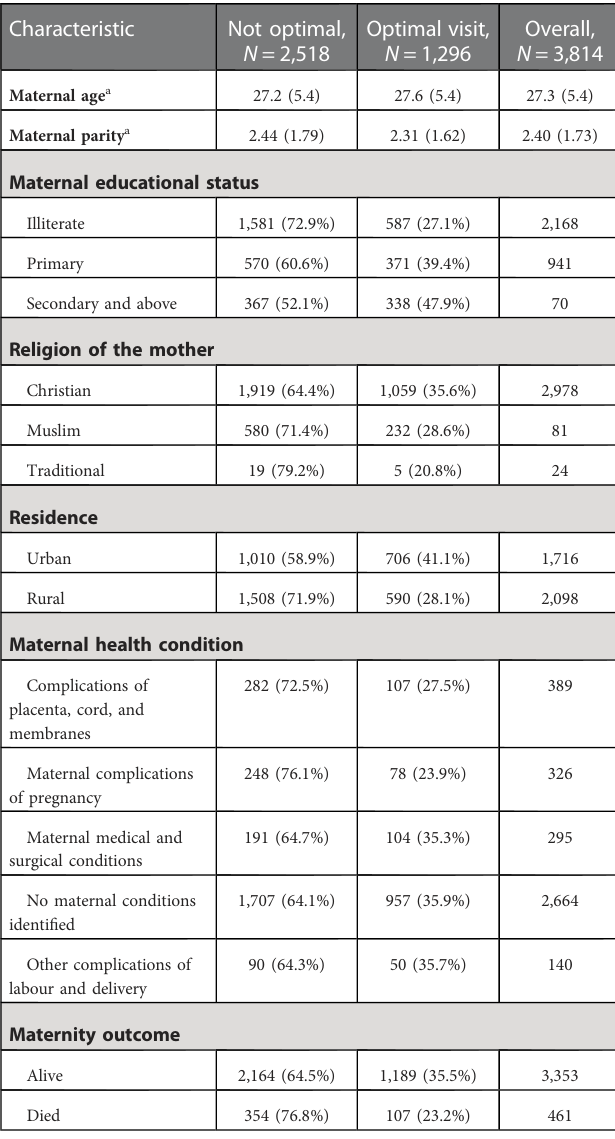
TABLE 4 Selected characteristics of the deceased perinate by the level of ANC follow-up in Ethiopia, 2021.